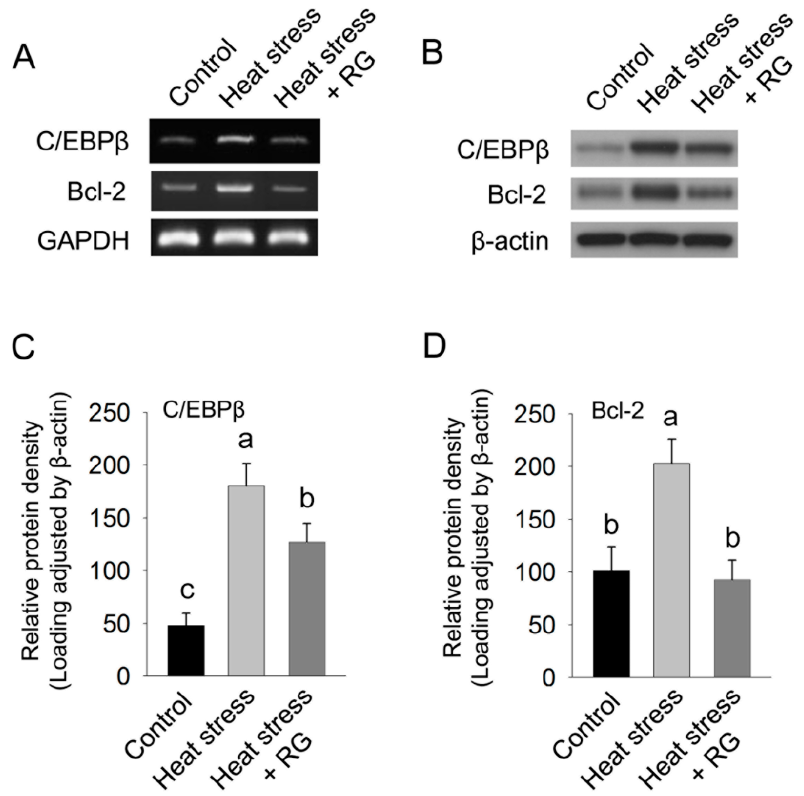
Figure 5. Red ginseng extracts (RG) suppressed the expression of C/EBP β and Bcl-2 induced by heat stress. ( A ) The protein level of C/EBP β , Bcl-2, and GAPDH was determined by semi-quantitative RT-PCR; ( B ) The protein level of C/EBP β , Bcl-2, and GAPDH was determined by western blotting; ( C ) The protein expression of C/EBP β was normalized by β -actin; ( D ) The protein expression of Bcl-2 was normalized by β -actin. The results are expressed as means ± standard deviation ( n = 8). Values with different letters are significantly different, p < 0.05.